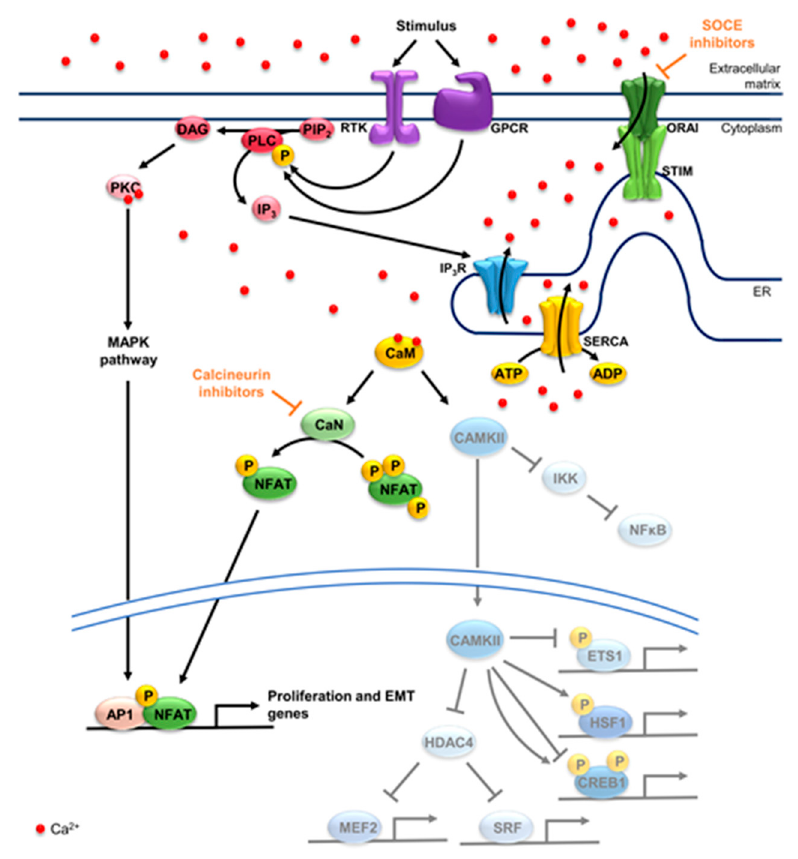
Figure 1. Calcium-dependent signaling and transcription factors. Upon a stimulus, GPCRs or RTKs are activated, phosphorylating PLC and promoting the breakdown of PIP2 to DAG and IP3. The latter promotes the opening of the channel IP3R, raising cytosolic calcium levels. STIM and ORAI further promote the influx of calcium into the cytoplasm through SOCE. DAG and calcium activate PKC and consequently the MAPK pathway, fostering AP1 activity. SERCA pumps calcium from the cytoplasm into the ER negatively regulating PKC. CaM binds calcium, activating CaN and CAMKII. CaN dephosphorylates NFATs, promoting its translocation into the nucleus, where it can dimerize with AP1, among other factors, to activate target genes. In the cytosol, CAMKII activates NF κ B by phosphorylating IKK2. CAMKII further activates HSF1, while repressing ETS1. CREB1 can be phosphorylated by CAMKII at two sites, one repressive (Ser142) and one activating (Ser133). CAMKII inhibits HDAC4, promoting the activation of MEF2 and SRF. SOCE inhibitors can be employed to target STIM1 or ORAI1 and consequently calcium-dependent programs, while calcineurin inhibitors block NFAT activation. In yellow are calcium pumps, in blue calcium channels and in green the components of SOCE, STIM and ORAI. Concerning signaling components, receptors are in purple and their downstream effectors in pink/red. Factors activated by CaN in green and factors activated and/or repressed by CAMKII in blue. GPCR: G protein-coupled receptor; RTK: receptor tyrosine kinase; PLC: phospholipase C; PIP2: phosphatidylinositol 4,5-bisphosphate; DAG: diacylglycerol; IP3: inositol 1,4,5-triphosphate; IP3R: IP3 receptor; STIM: stromal interaction molecule; ORAI: